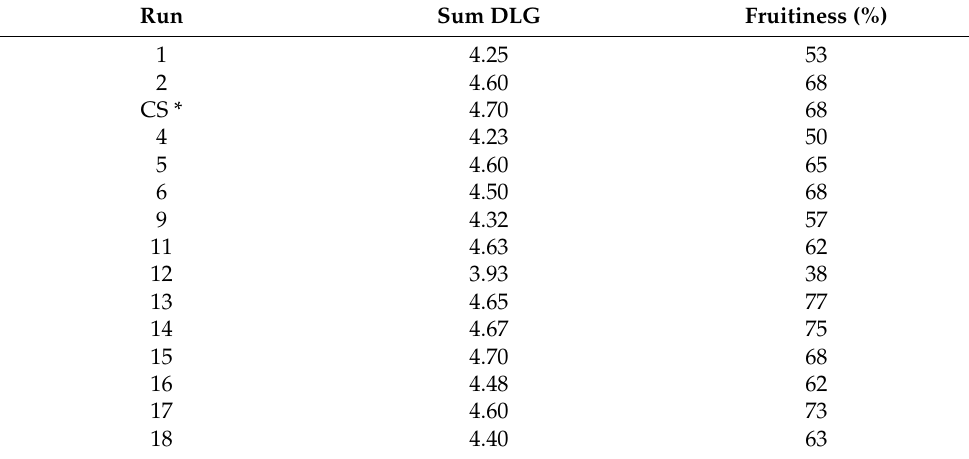
Table 7. Sensory evaluation results as sum DLG and fruitiness (%) of 15 beer samples with six center points summarized as composite sample